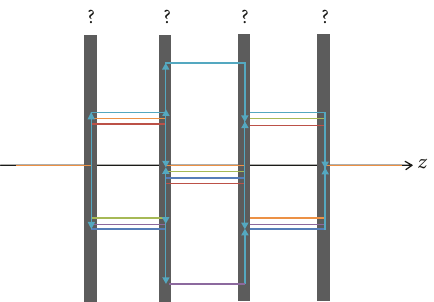
Figure 1: Possible electrostatic field configurations inside a four- charged-plane system where the charge distribution is not